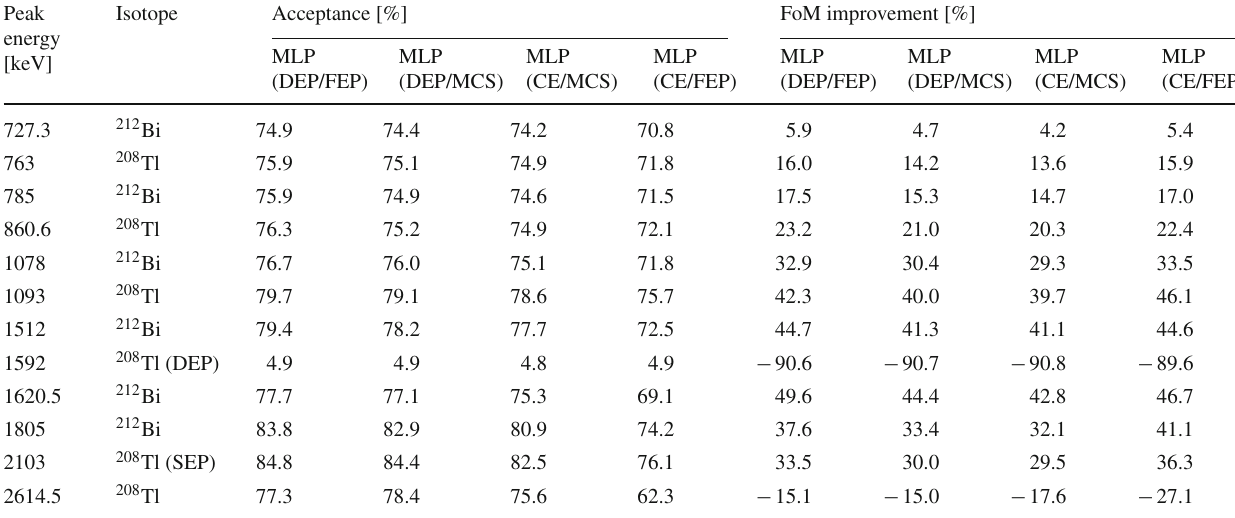
Table 1 Reduction of peaks area and Figure of Merit improvement after application of the MSE PSA cut (for each training variant the DEP events acceptance was set to 5%) Peak